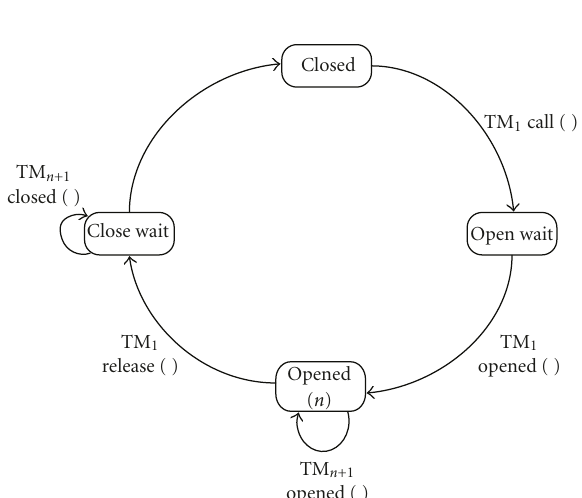
Figure 8: Sequence diagram for connection establishment and connection